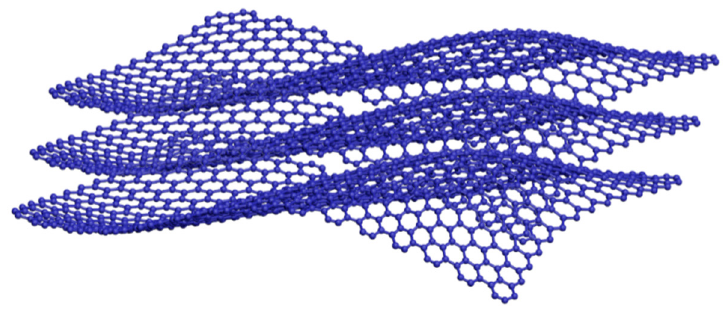
Figure 4. The graphene layers.